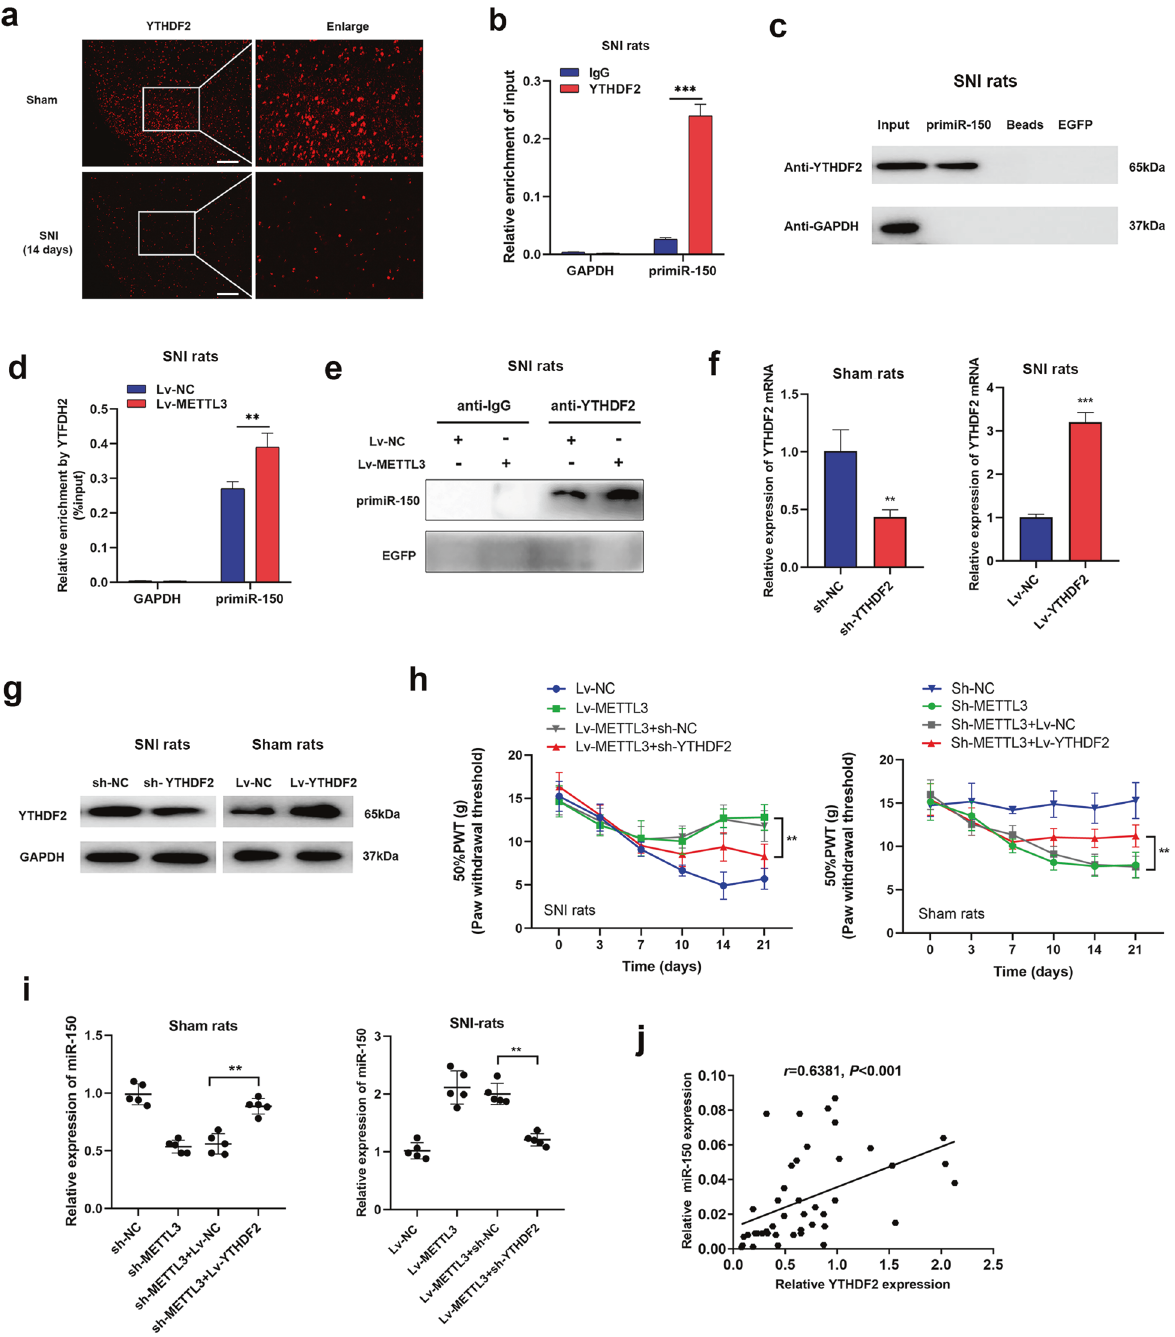
Fig. 4 YTHDF2 cooperating with METTL3 regulates m6A methylation of primiR-150. a Immuno fl uorescence assay of YTHDF2 expression in spinal cord tissues from SNI rats at day 14 after model establishment, and red signals showed the positive staining sites. Scale bar = 100 μ m. b RIP assay showed an increased binding of primiR-150 by YTHDF2, GAPDH mRNA was set as a nontarget control. *** P < 0.001. c RNA pulldown assay proved that the YTHDF2 protein was directly associated with primiR-150, EGFP RNA was used as RNA control. d RIP assay of the enrichment of primiR-150 by YTHDF2 in SNI rats overexpressed METTL3, and an increased enrichment caused by METTL3 was obtained, GAPDH mRNA was used as a nontarget control. ** P < 0.01. e RNA-pulldown assay was performed in SNI rat overexpressed METTL3, and the YTHDF2 pull down by primiR-150 was signi fi cantly elevated upon upregulation of METTL3, EGFP RNA was set as RNA control. f , g Veri fi cation of the manipulations of YTHDF2 in SNI or sham rats at transcript ( f ) and protein levels ( g ). N = 3, ** P < 0.01, *** P < 0.001 in comparison with the control group. h PWT of rats in the respective groups was performed when METTL3 and YTHDF2 were co-expressed. The results proved that YTHDF2 could effectively reverse the effects on PWT caused by METTL3. N = 5 biological replicates. ** P < 0.01 compared with the control group. i Mature miR-150 expression was detected via qRT-PCR in sham and SNI rats after injection of METTL3 and YTHDF2. YTHDF2 could effectively reverse the effects on miR-150 expression mediated by METTL3. N = 5 biological replicates. ** P < 0.01. j YTHDF2 and mature miR-150 levels were detected in 45 clinical NP patients and the two transcripts were positively expressed according to Spearman correlation test.